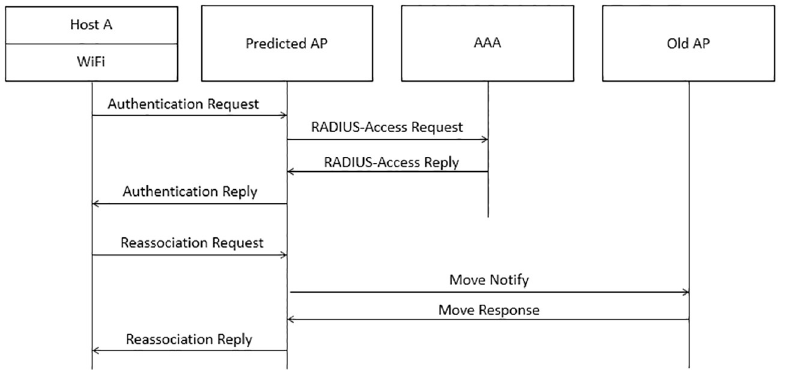
Fig 17. Homogeneous handover between WiFi